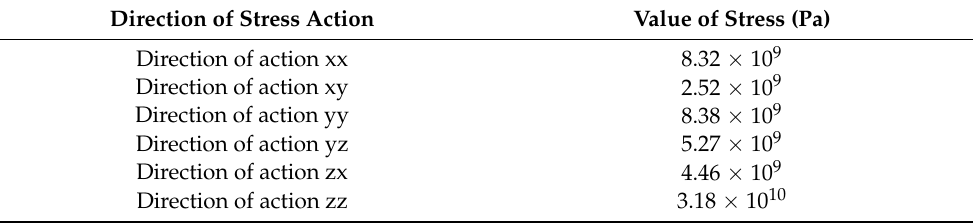
Figure 7. Overall residual stress acting during manufacturing of shaped intermediate piece via the DMLS technology. Table 1. Maximum stress in individual directions .